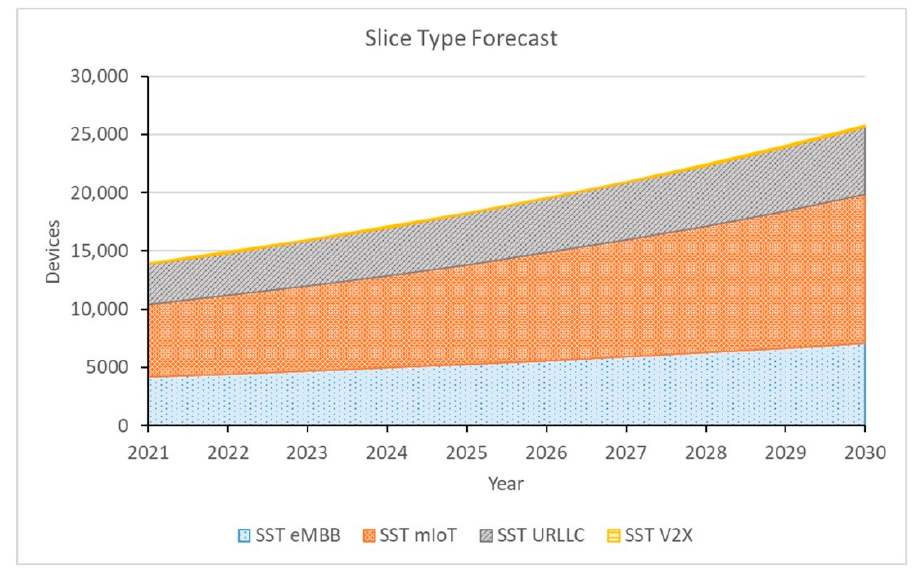
Figure 4. Slice Type Forecast for 2021–2030.